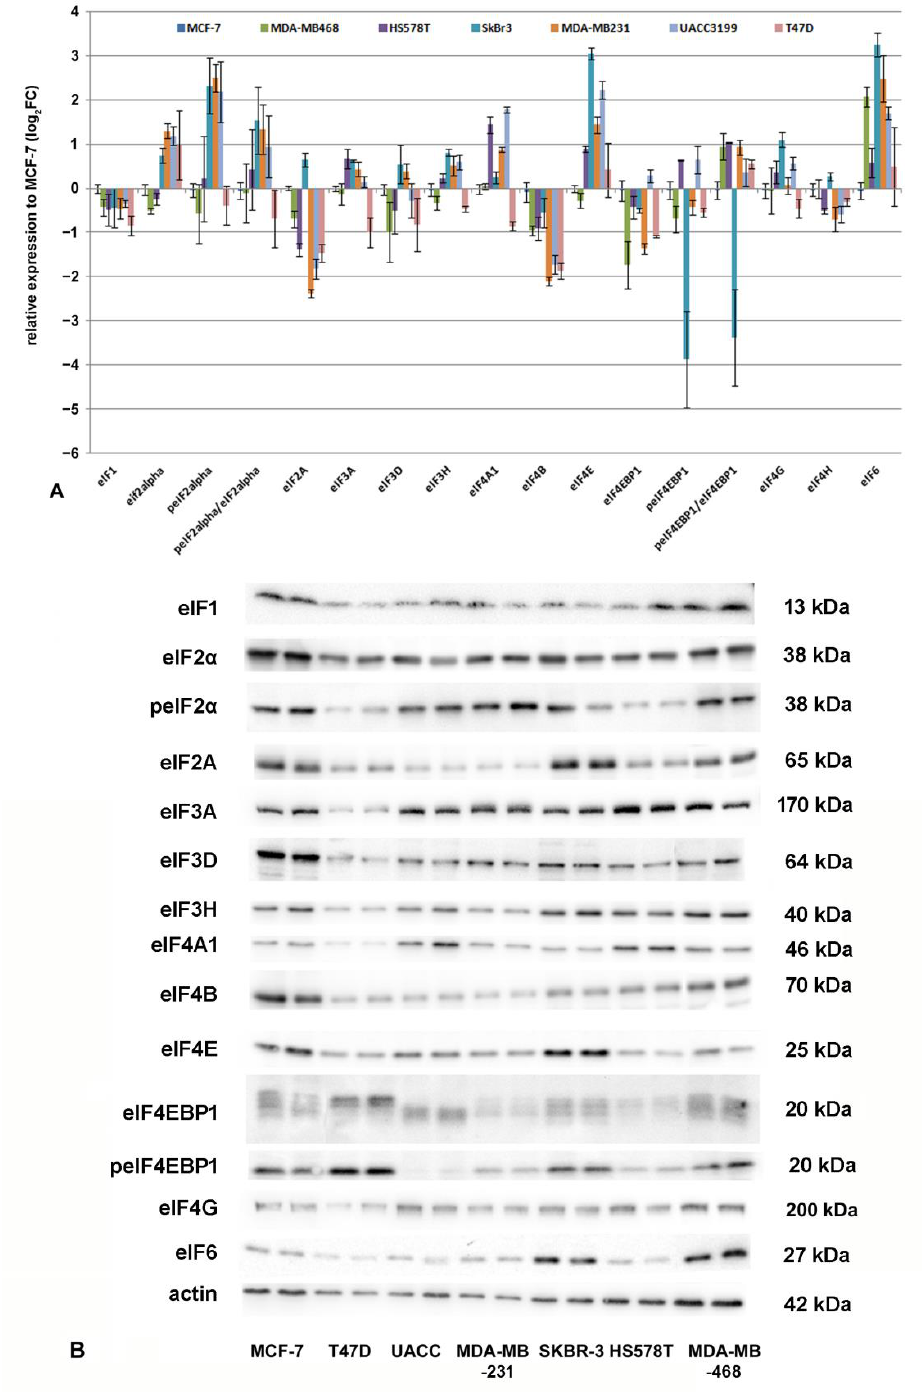
Figure 6. ( A ) Expression of eIFs relative to β -actin in breast cancer cell lines, as determined by Western blotting. A: Relative expression towards MCF-7 is shown as log 2 Fc. Error bars indicate standard error SEM (n = 4). ( B ) Representative Western blots of eIFs in breast cancer cell lines. Log 2 Fc values and statistical analysis by ANOVA and post hoc tests results are summarized in Table